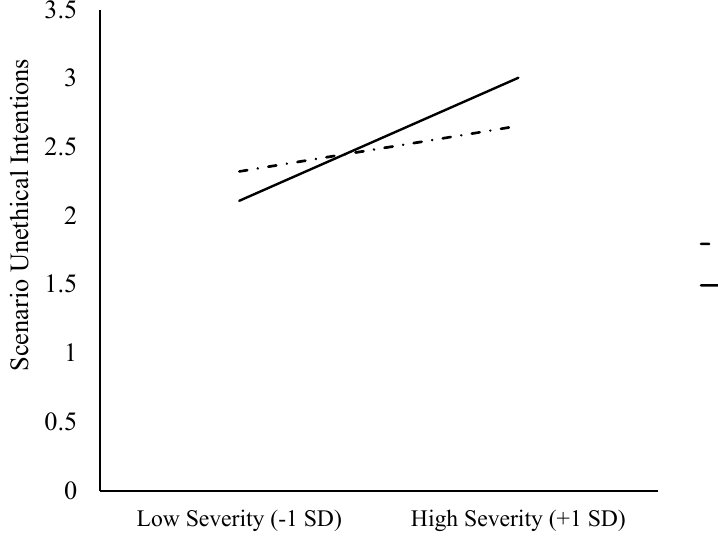
Figure 1. Unethical intention scenarios as functions of epidemic severity and SES (Study 1).